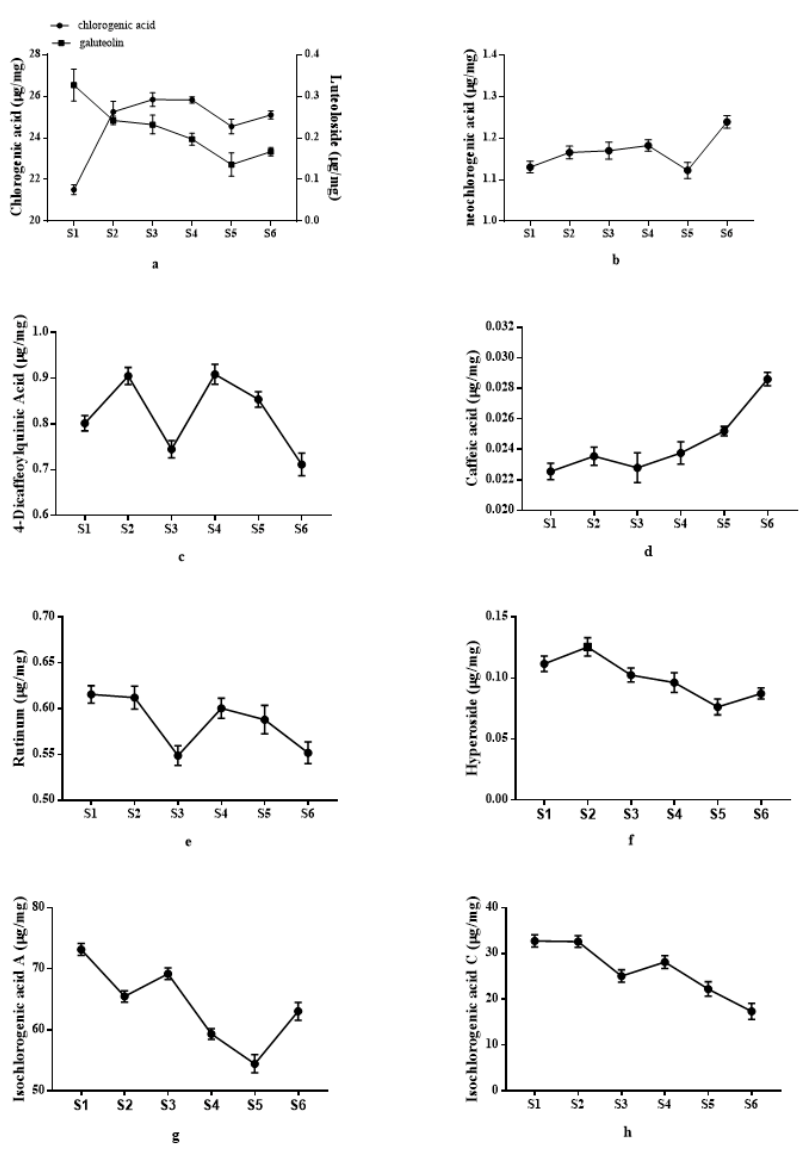
Fig. 5: Dynamic accumulations of chlorogenic acid and luteoloside (a), neochlorogenic acid (b), 4-dicaffeoylquinic acid (c), caffeic acid (d), rutin (e), hypero- side (f), isochlorogenic acid A (g), and isochlorogenic acid C (h) in the flower buds of L. fulvotomentosa at different growth stages from